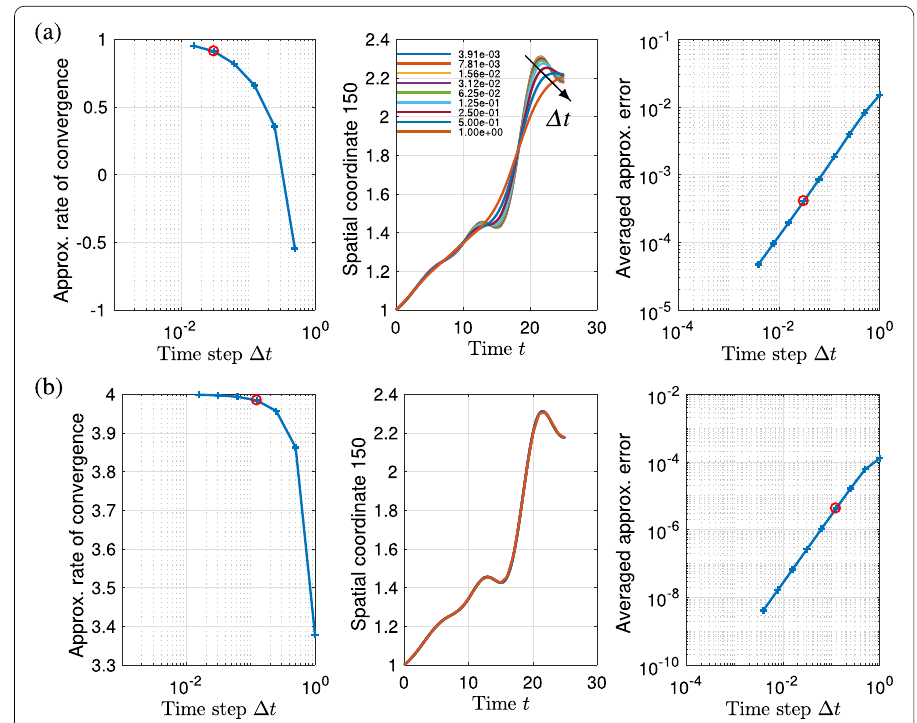
Fig. 1 Timestep verification for 1D inviscid Burgers’ equation: a backward-Euler integrator: we select a time step of 3 . 12 e -2, as it leads to an approximated convergence rate of 1 and an approximated error of 4 e -4 for the selected state; b Runge–Kutta: we select a time step of 1 . 25 e -1, as it leads to an approximated ( < 1% error) convergence rate of 4 and an averaged approximated error of 6 e -5 for the selected